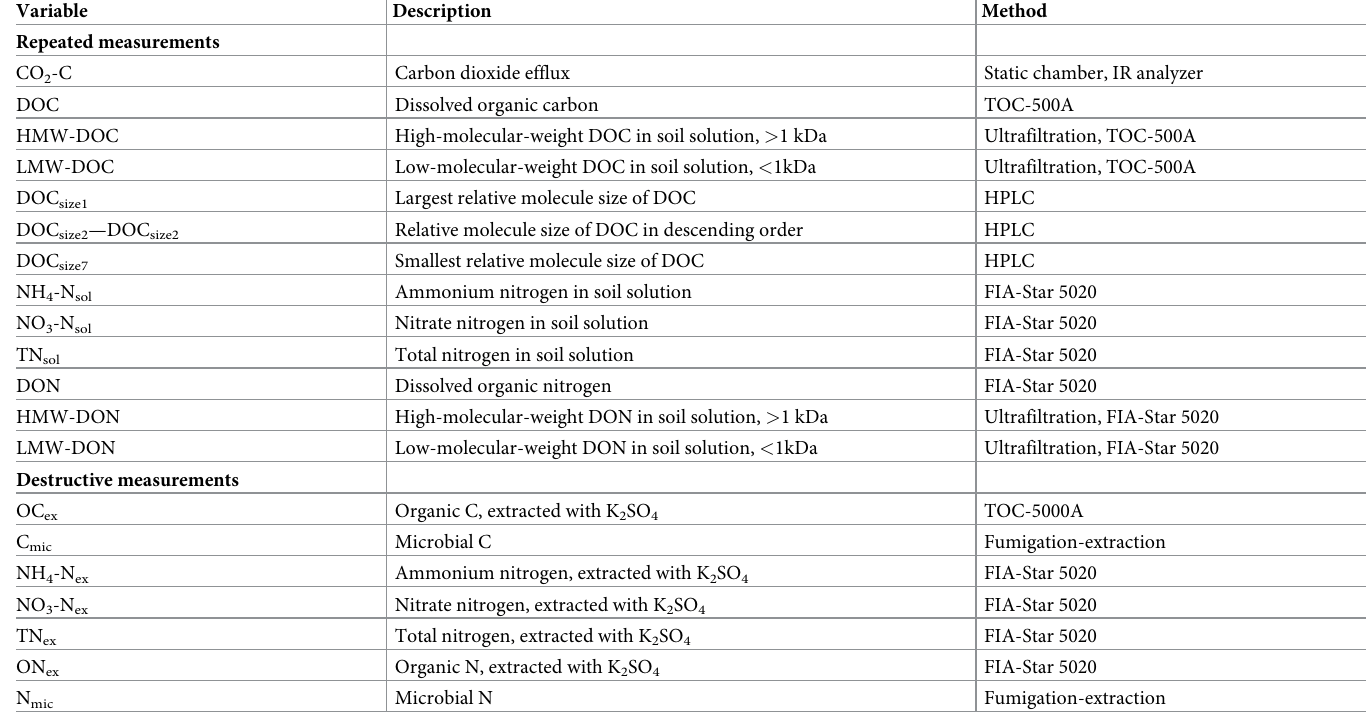
Table 1. Abbreviations and description of the measured compounds in the multifactorial